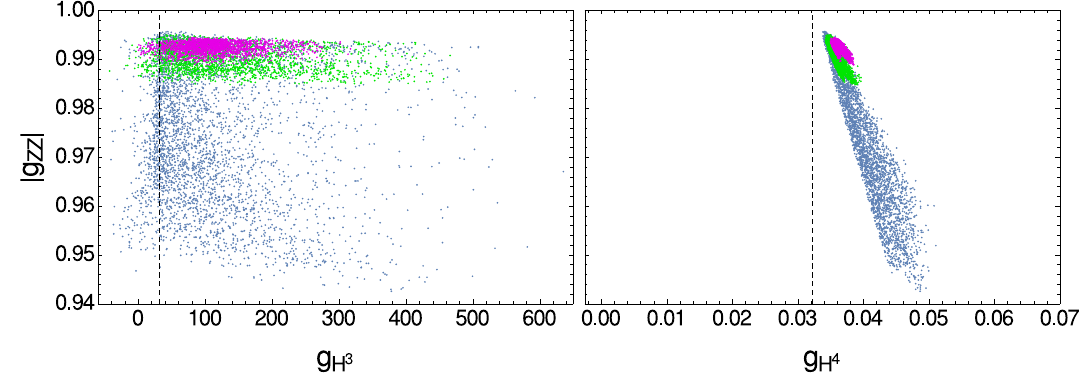
Figure 9 . Scatter plots of g ZZ versus g H 3 and g H 4 . The notation for the colours of the points is | | the same as in figure 4. The dashed vertical lines indicate the values of g H 3 and g H 4 in the